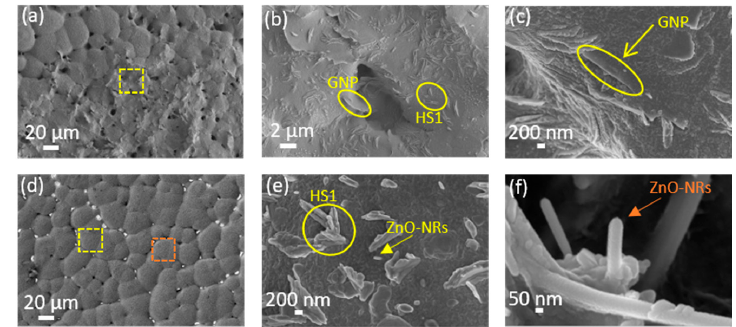
Figure 4. FE-SEM low-magnification and high-magnification micrographs of the sample M2-HS1-GNP ( a – c ), and of the sample M2-HS1-ZnO ( d – f ).